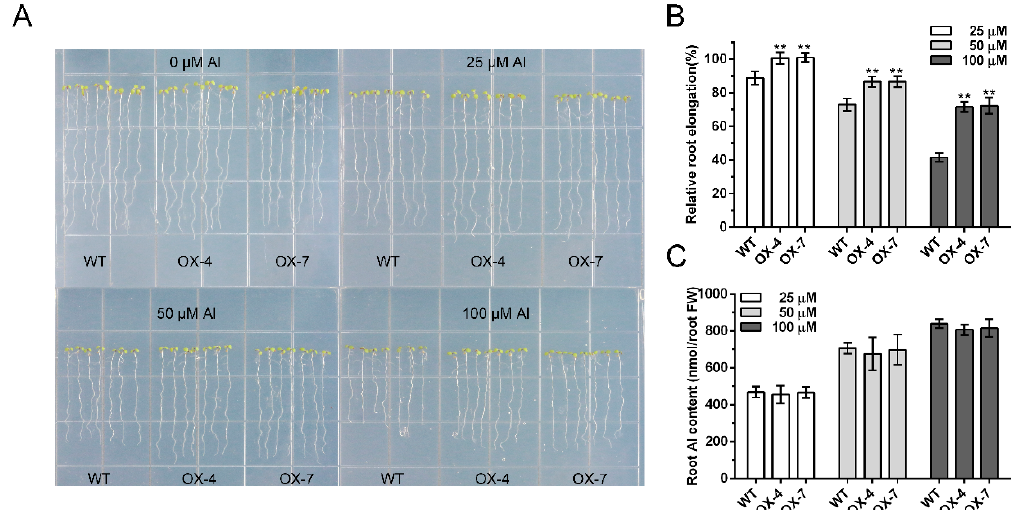
Figure 5. Overexpression of GmIREG3 enhances Al tolerance in Arabidopsis . ( A ) Evaluation of Al tolerance in GmIREG3 overexpression lines. After germination in MS medium, five-day-old seedlings were transferred to solid agar medium supplied with 1 mM CaCl 2 and 1% sucrose containing different concentrations of AlCl 3 (0, 25, 50 or 100 µM; pH 4.5) for 3 d. The photograph was taken for different treatments at the end of the experiment. The relative root elongation ( n = 14) ( B ) and root Al concentration were measured ( n = 3) ( C ). All data are presented as means ± SD. Significant differences according to the one-way analysis of variance are denoted as follows: ** p < 0.01.